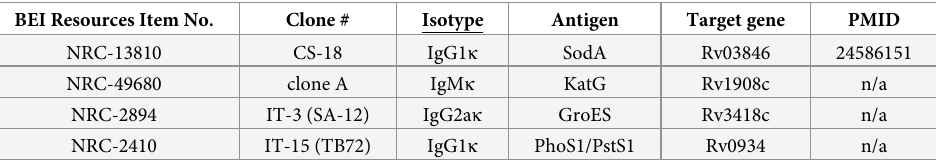
Table 4. List and features of BEI resources M . tuberculosis hybridomas in this study. BEI Resources Item